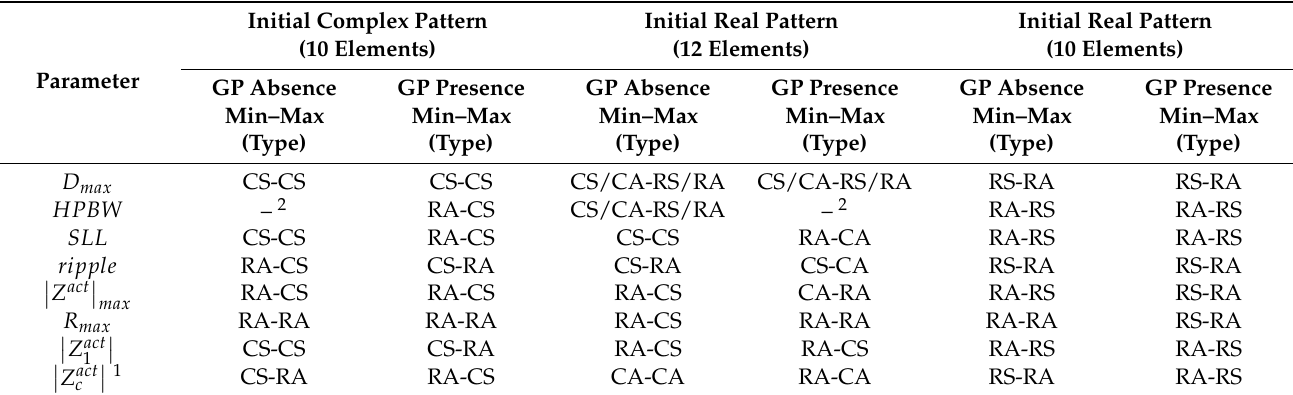
Table 6. Nature of the solutions related to the maxima and minima bandwidths in terms of quality parameters of the pattern and selected terms for linear antenna array half-wavelength elements. Linear arrays in absence and presence of ground plane.